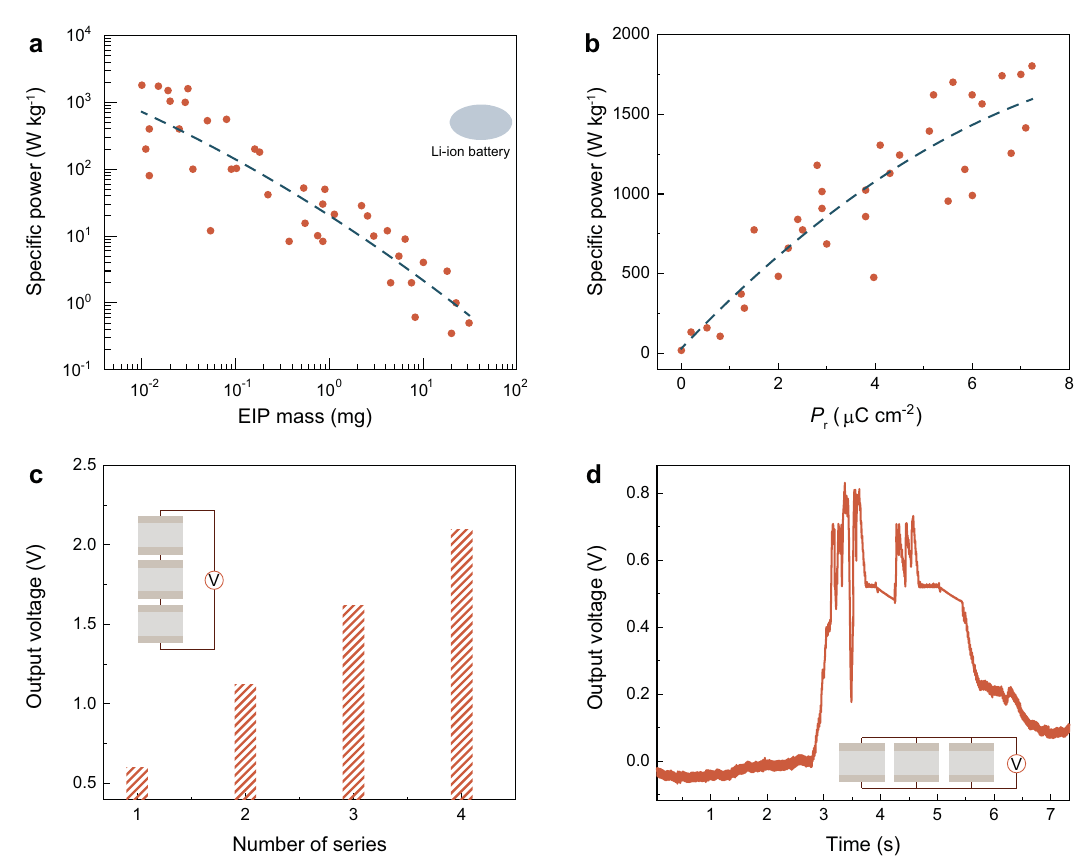
Fig. 4 Chemical driven electricity performance in EIP. a The speci fi c peak power plotted as a function of EIP mass. Two kinds of EIP devices are prepared. One is made by EIP crystals with sliver epoxy electrode. The other one is made by EIP thin fi lms in the range of (1 – 100) μ m on the prepatterned indium tin oxide substrate (50 μ m channel length). b P r dependence of speci fi c power. c Enhanced output voltage achieved by series con fi guration circuit. d Extended working time by parallel con fi guration circuit. For devices in the series and parallel con fi guration circuit test, the gap distance between the electrodes is 1.2 mm and the cross-sectional area is 16 mm 2 for each